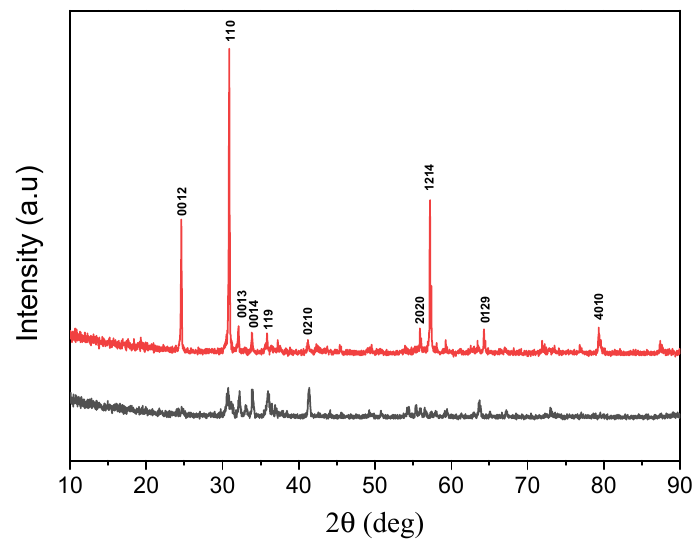
Figure 6. X-ray diffraction diagrams. Sample N1 (black), sample N2 (red).